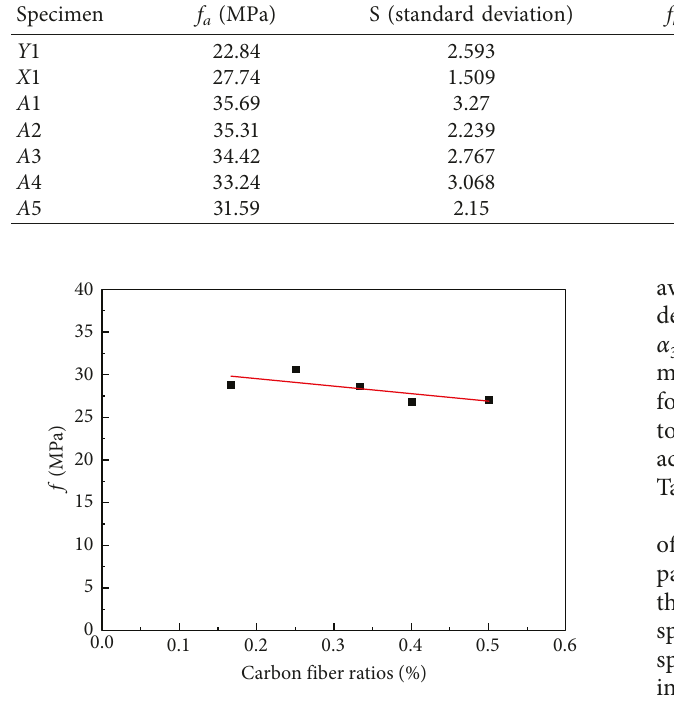
Figure 7: Compressive strength of specimens with different carbon fiber